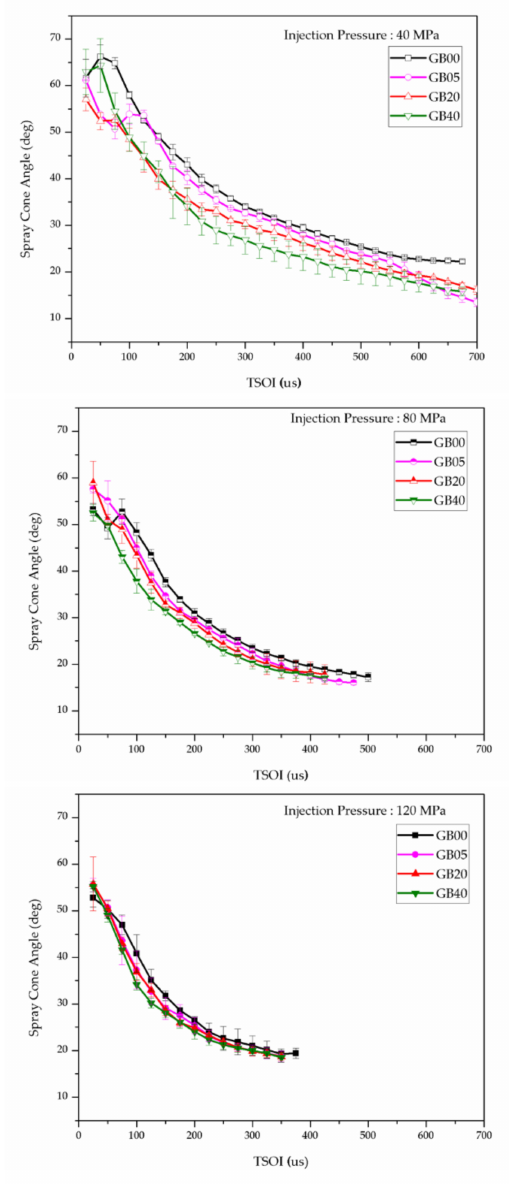
Figure 13. Spray cone angle of GB fuels according to the injection pressure. Top row: 40MPa, Middle row: 80 MPa, Bottom row: 120 MPa (GB00: gasoline 100% and biodiesel 0%, GB05: gasoline 95% and biodiesel 5%, GB20: gasoline 80% and biodiesel 20%, GB40: gasoline 60% and biodiesel